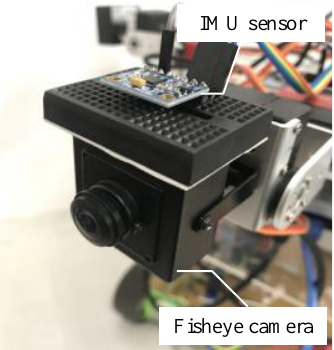
Figure 8. The experimental setup includes the fisheye camera and an IMU sensor as a GY-85